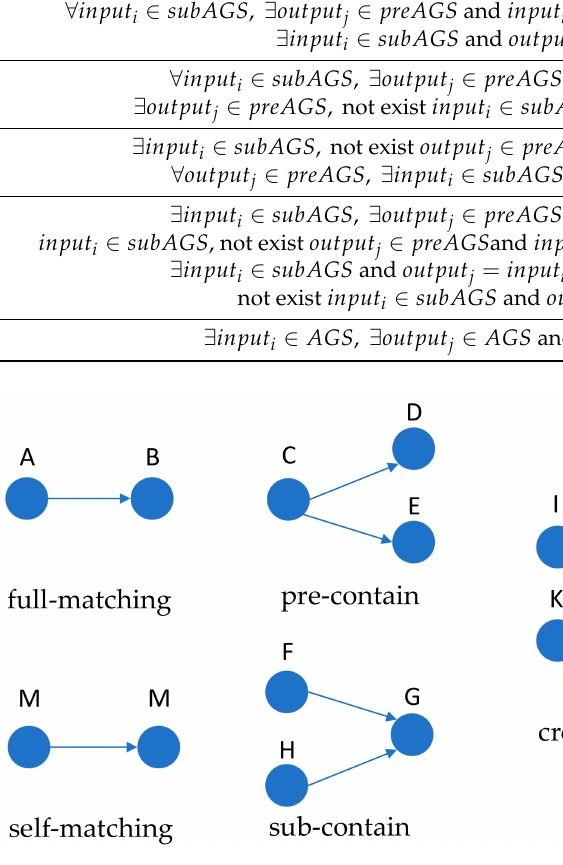
Figure 4. Abstract geospatial service relationship. This figure shows five relationships between geospatial services; the specific relationships are full-matching (A, B), pre-contain (C, D), pre-contain (C, E), sub-contain (F, G), sub-contain (H, G), cross-matching (K, J), self-matching